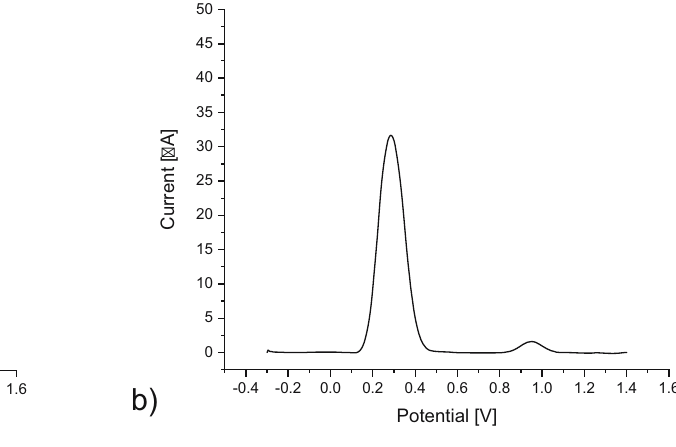
Figure 2: SWV signals for P. padus ( a ) and P. serotina ( b ) leaf